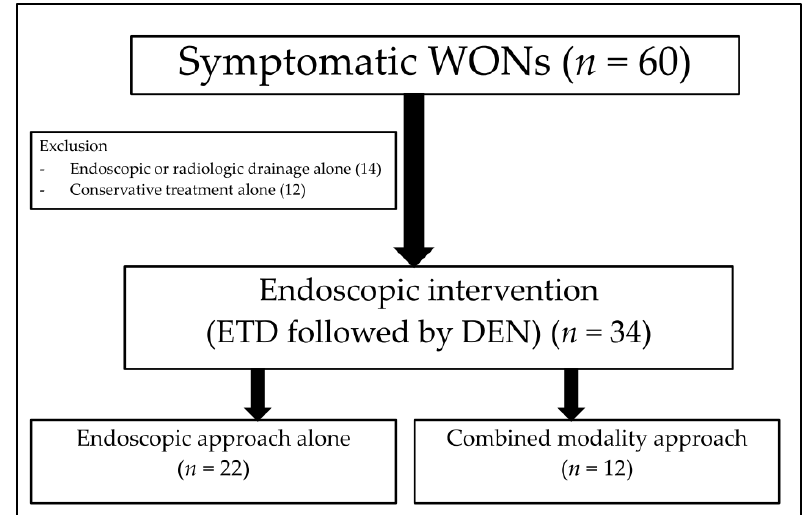
Figure 1. The consort diagram of the study.